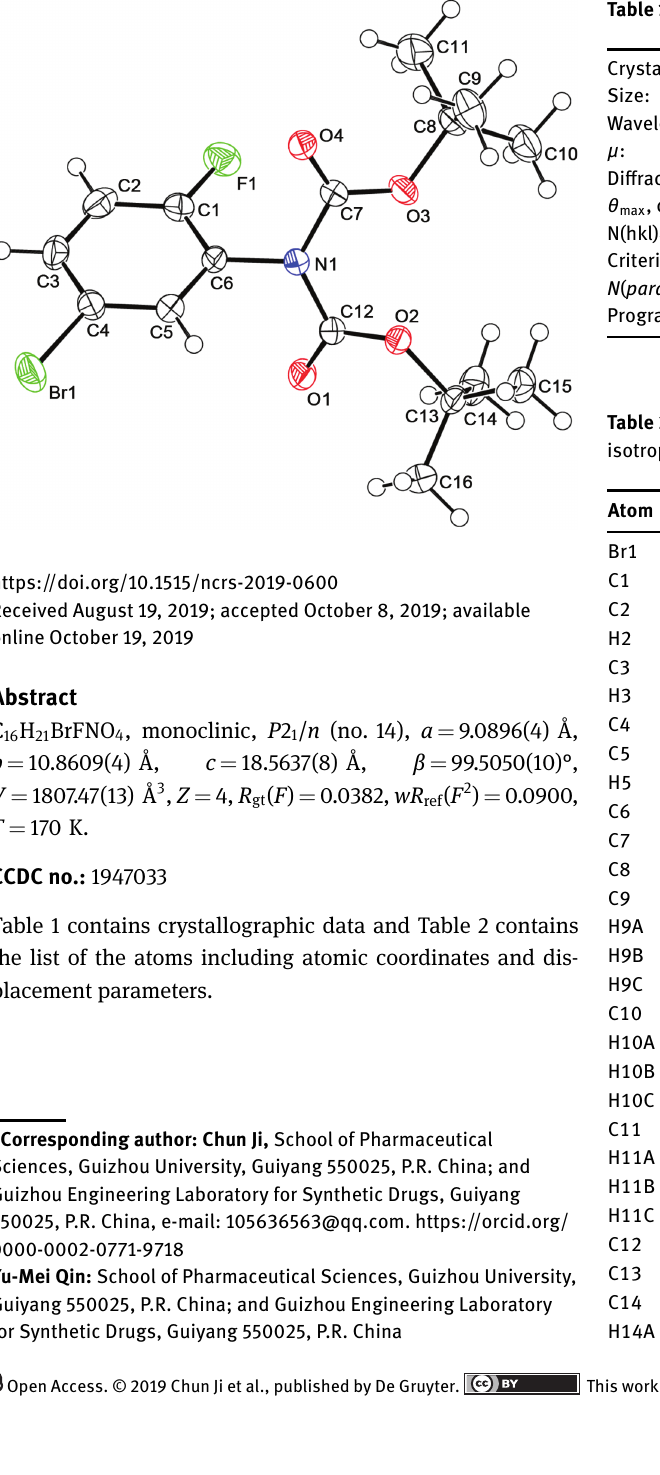
Table 1: Data collection and handling.